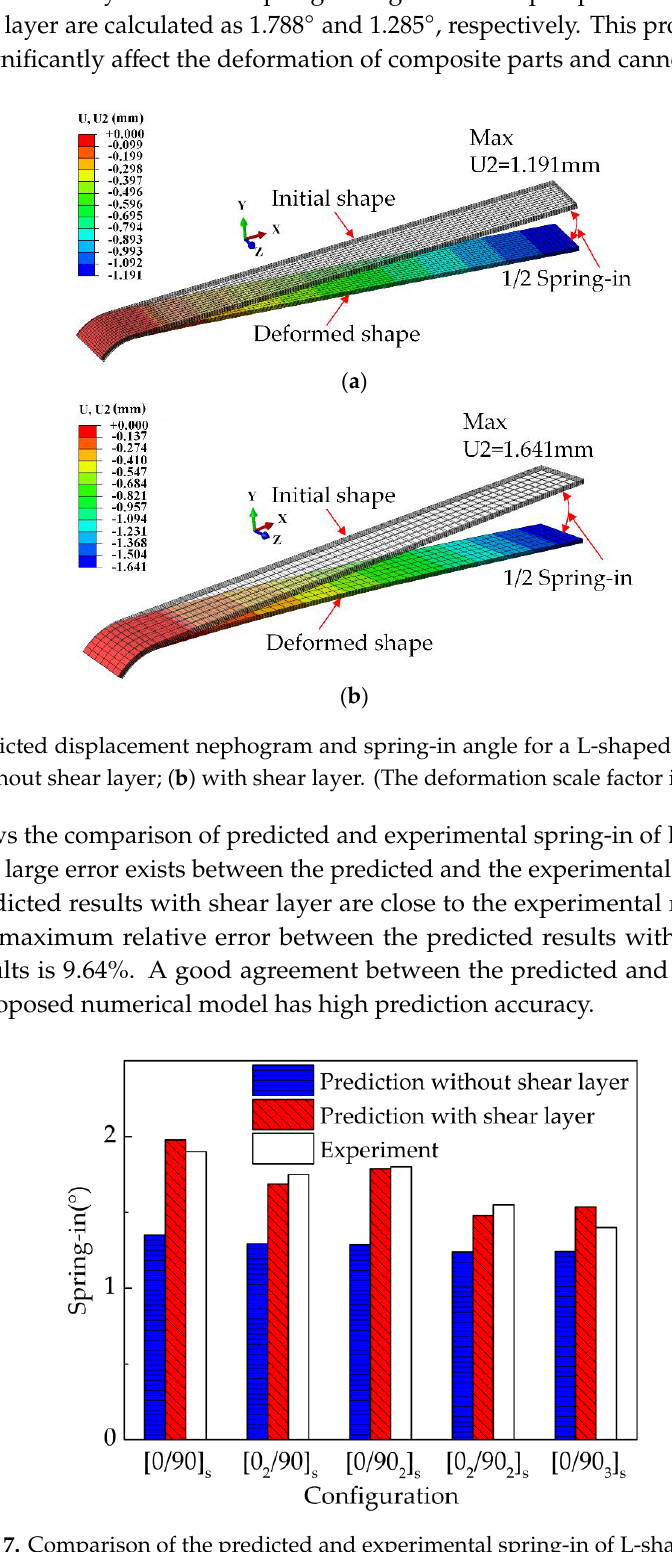
Figure 7. Comparison of the predicted and experimental spring-in of L-shaped parts.